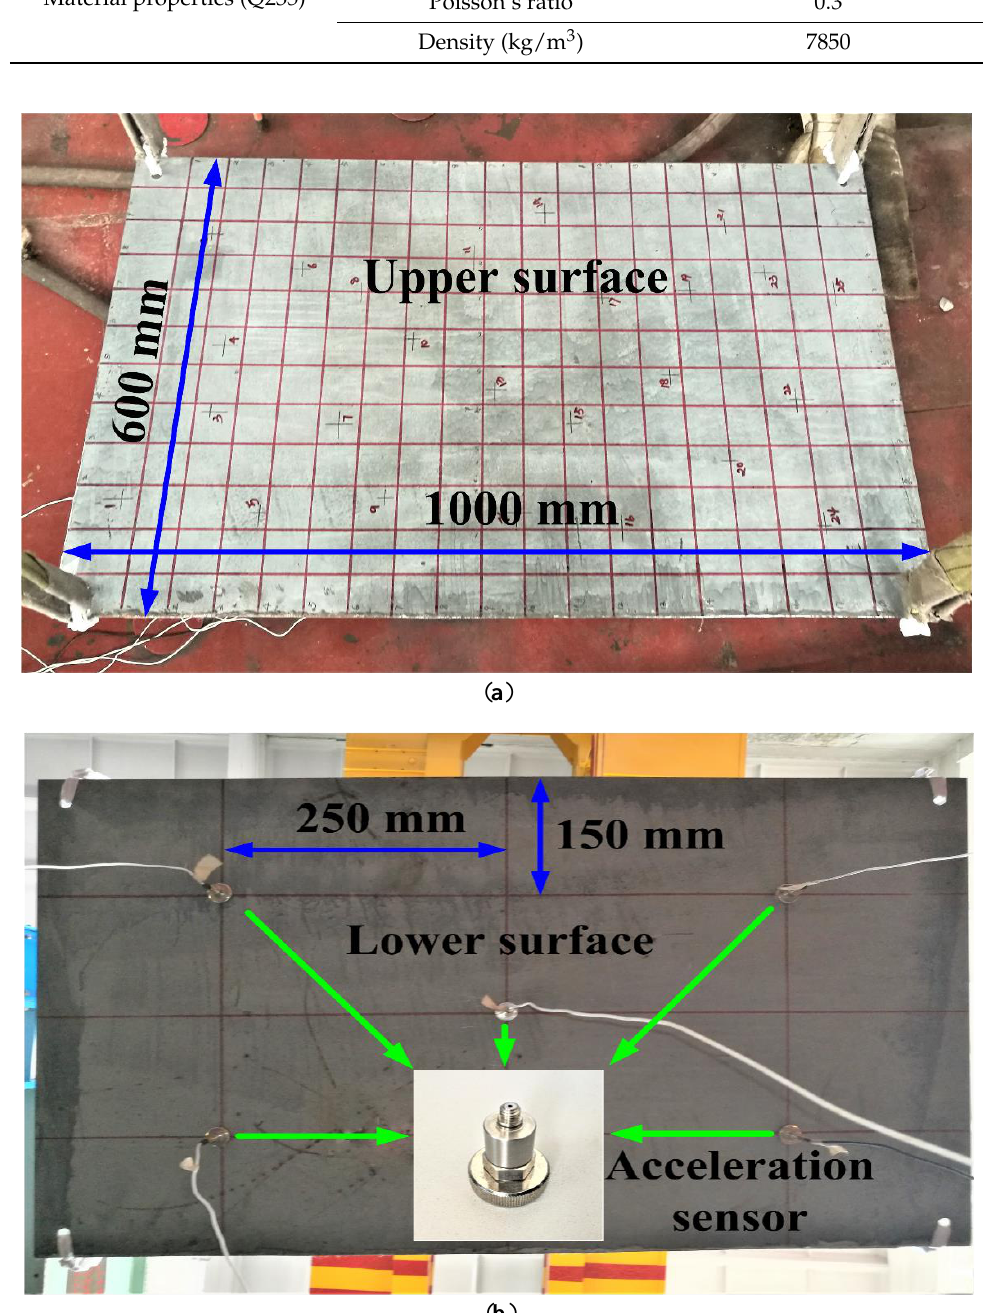
Figure 2. Upper surface ( a ) and lower surface ( b ) of rectangular steel plate. Due to the four hanging holes, the survey region enclosed by the red solid lined box is at a certain distance from the upper and lower boundaries of the plate. A certain number of seeds were disposed on the surrounding boundary of the rectangular steel plate and then a grid was constructed according to the distribution of seeds, which was described in our previous study. Details are available in Figure 3a. Therefore, there were 162 grid nodes (reference points) in the selected survey region where impact forces were applied. For different approaches, the naming rules of the reference points are different. For the conventional optimisation algorithm, the reference points are marked in a left-to-right and top-to-bottom order, as shown in Figure 3a. In addition, 25 randomly generated green points on the survey region represented the validation points. The serial numbers of all validation points are also specified in Figure 3a. However, for the PRMCSM algorithm and the proposed hybrid algorithm, the sur- vey region should be segmented due to the introduction of the classification concept. Ac- cording to the division rule proposed in [42,43] for the PRMCSM algorithm, there are 18 small areas in the survey region presented in Figure 3b and nine reference points that are evenly distributed on each small area. The first small area in the upper left corner of the survey region is denoted as “Area 1”, and the divided areas are also marked in a left -to- right and top-to-bottom order. Similar to the naming rule of the areas, the nine reference points in each small area are designated as R1 – R9 and are arranged in a left-to-right and top-to-bottom order. In order to distinguish the reference points of different areas, they are renamed by adding the letter A and the area number, which is shown in the partially enlarged image of Figure 3b.